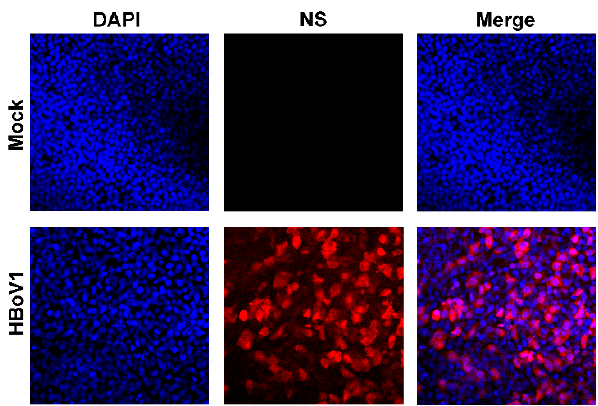
Figure 1. HBoV1 infection of HAE-ALI cells. HAE-ALI cultures were infected with HBoV1 at an MOI of 1000 vgc/cell, or mock-infected. At 7 days post-infection, the pieces of the inserts were fixed and subjected to direct immunofluorescence analysis. The membranes were stained with anti-HBoV1 NS1C antibody that detected all NS1-4 proteins. Images were taken using an Eclipse C1 Plus (Nikon) confocal microscope under 40 × , which was controlled by Nikon EZ-C1 software. The nuclei were stained with DAPI (blue).